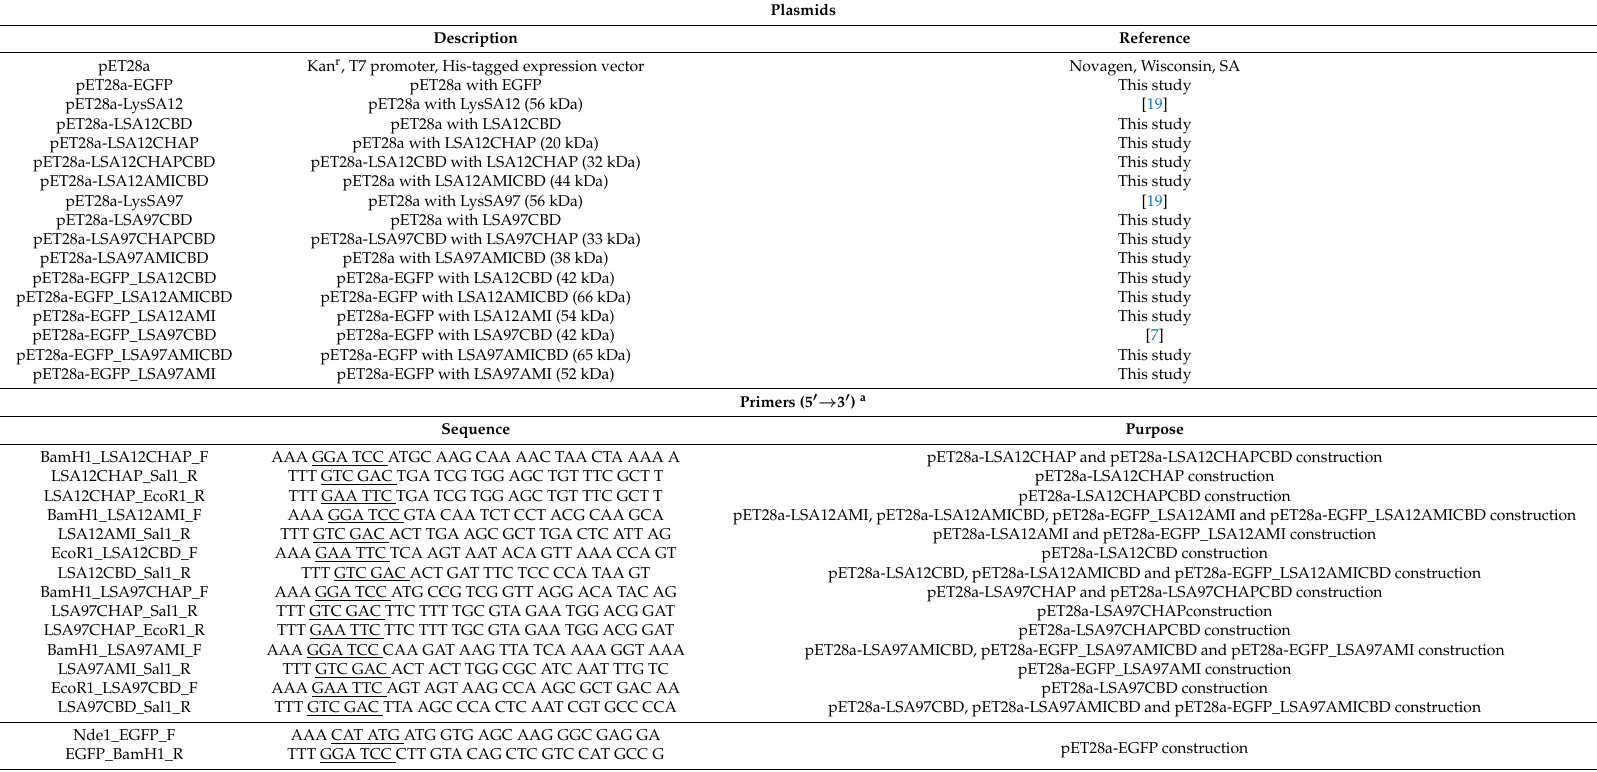
Table 1. Plasmids and primers used in this